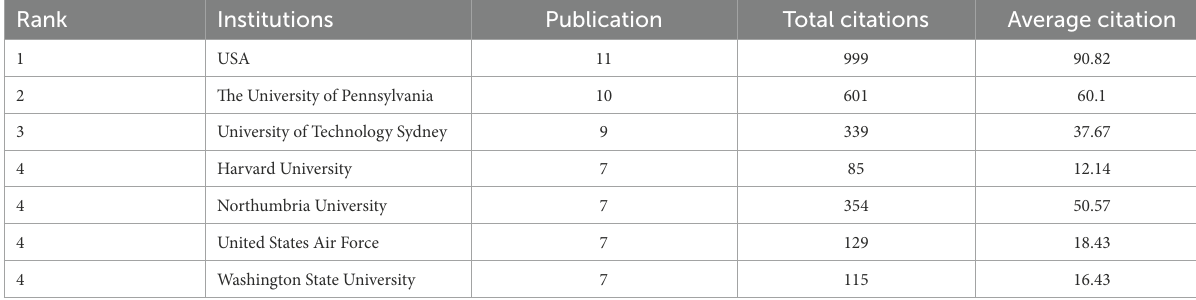
TABLE 3 Top 5 institutions by number of publications and total